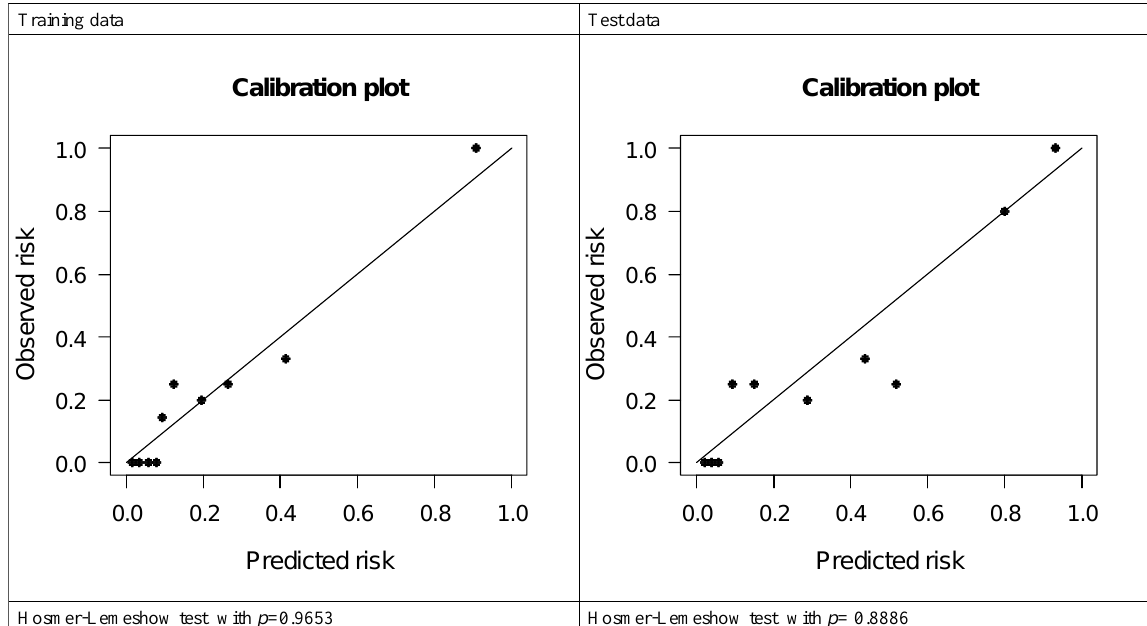
Figure 3. Calibration plot for predicting LECS requirement during endoscopic resection.